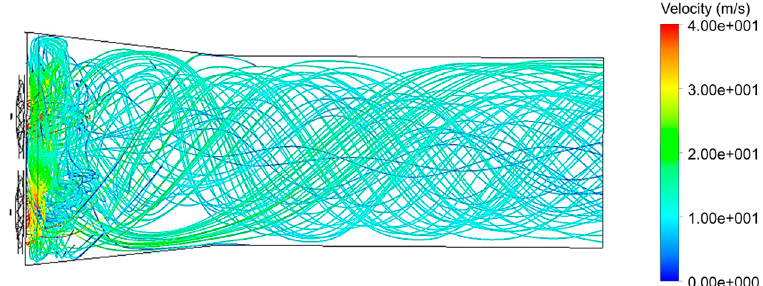
Figure 11. Airflow streamlines in the return airway.